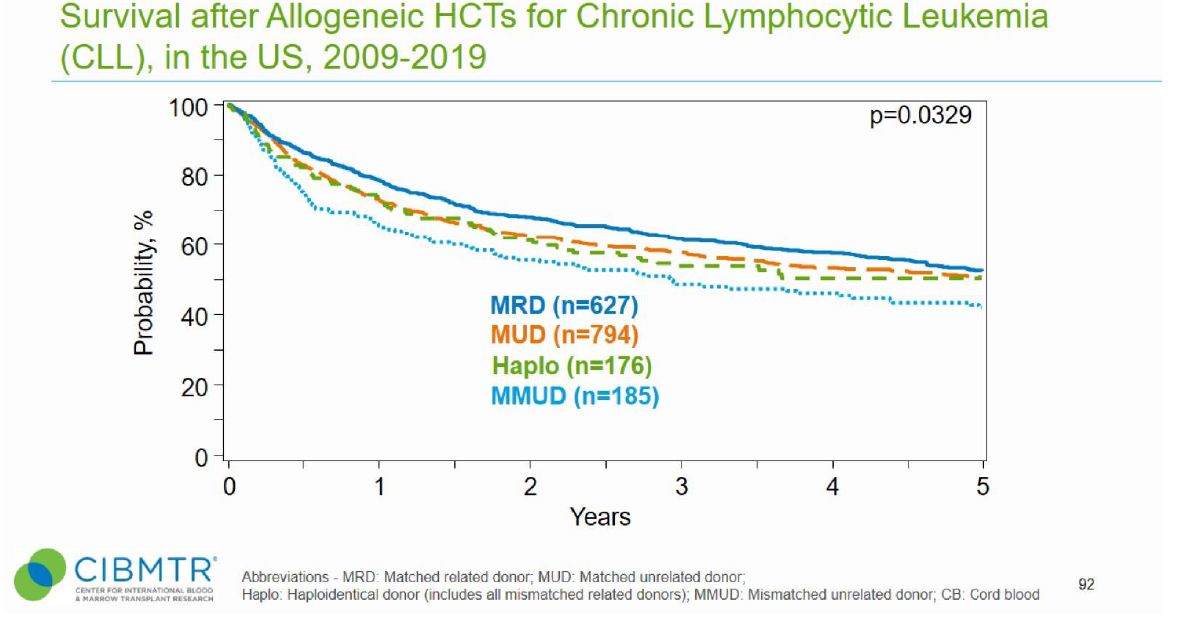
Figure 1. Survival following allogeneic hematopoietic stem cell transplants in the US. Source: CIBMTR.